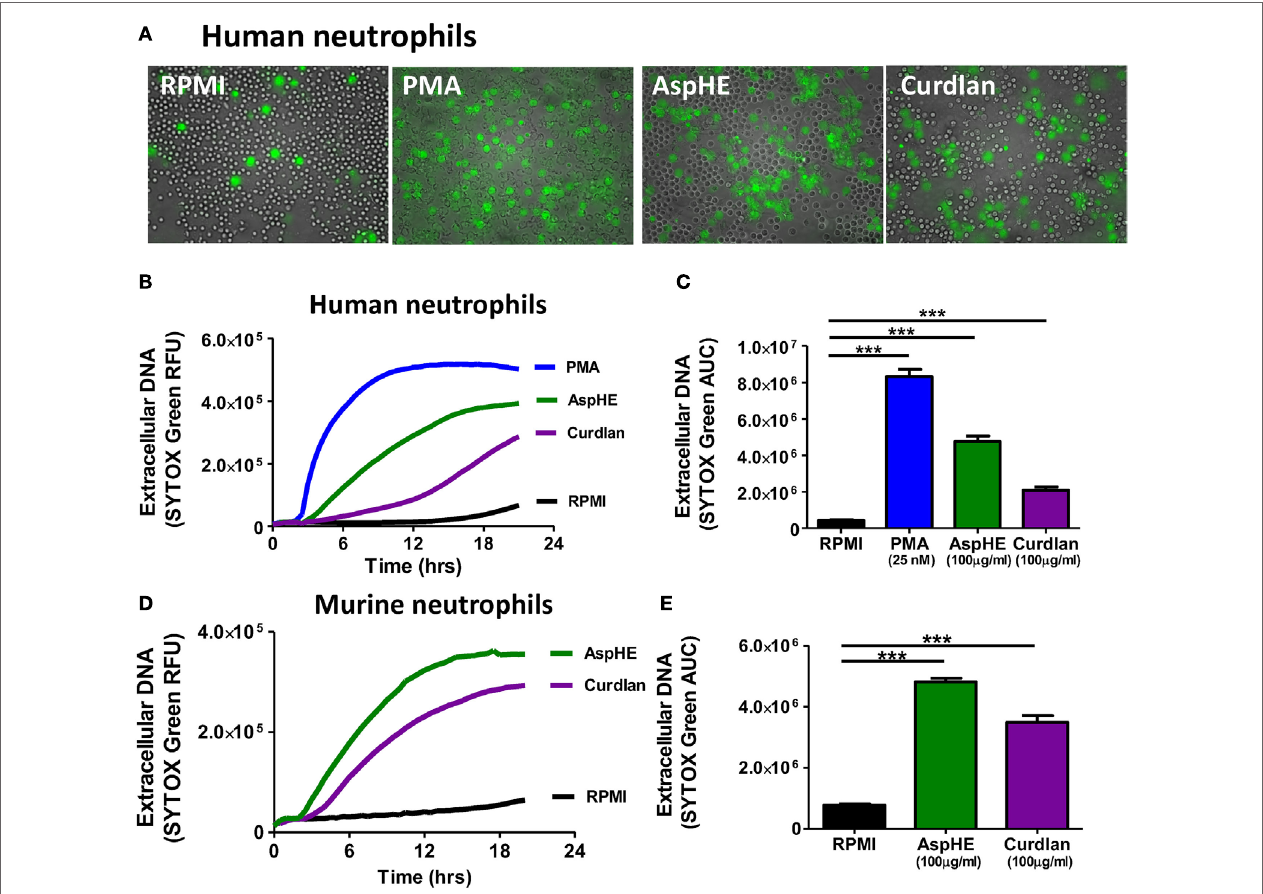
FigUre 1 | Aspergillus fumigatus and β -glucan induce neutrophil extracellular trap formation in human and murine neutrophils. (a) Representative images showing DNA release by SYTOX Green staining in human peripheral blood neutrophils 20 h after stimulation with 25 nM phorbol myristic acid (PMA), 100 μ g/ml A . fumigatus hyphal extract (AspHE), or 100 μ g/ml particulate β -glucan (curdlan); original magnification is 200 × . (B) DNA release overtime shown as relative fluorescent units (RFU) measured by SYTOX Green; (c) total extracellular DNA after 20 h calculated as area under the curve (AUC). (D,e) Extracellular DNA from mouse peritoneal neutrophils incubated with AspHE or curdlan and quantified by SYTOX Green RFU and AUC. Asterisks (***) indicate p < 0.001 based on one way ANOVA with Tukey post hoc analysis. Experiments were repeated five times with similar